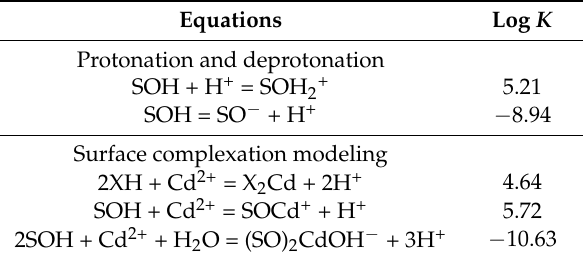
Table 5. The optimized parameters of surface complexation modeling of Cd(II) on Mn